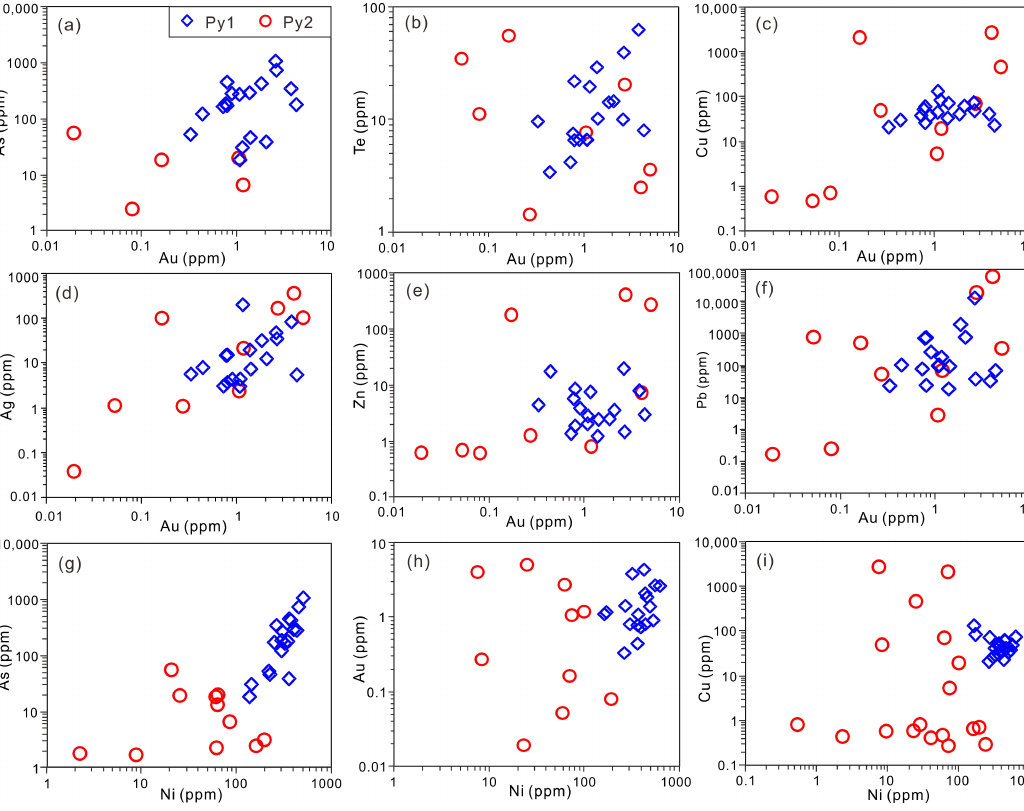
Figure 4. Scatterplots of ( a ) As vs. Au, ( b ) Te vs. Au, ( c ) Cu vs. Au, ( d ) Ag vs. Au, ( e ) Zn vs. Au, ( f ) Pb vs. Au, ( g ) As vs. Ni, ( h ) Au vs. Ni, and ( i ) Cu vs. Ni in the two types of pyrite (Py1 and Py2) from the Huanxiangwa deposit.